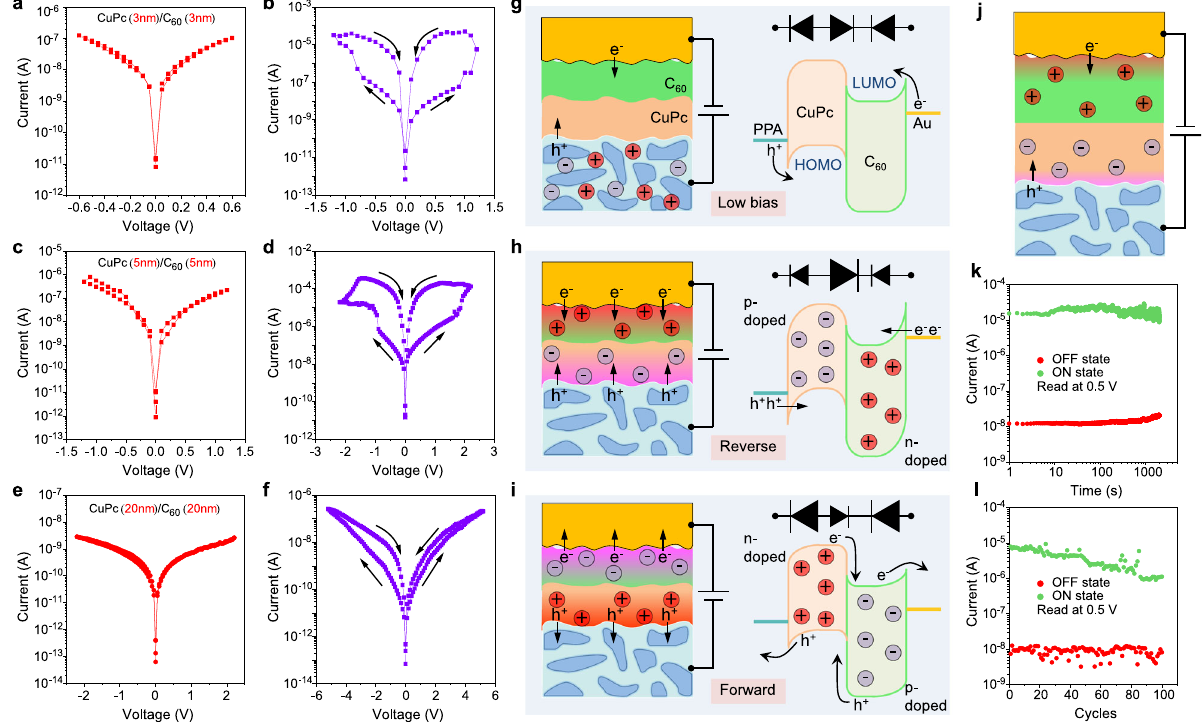
Fig. 4 Molecular bipolar memristors based on PPA60/CuPc ( x nm)/C 60 ( x nm)/Au tube. a – f I - V characteristics of the molecular devices in different voltage windows (( a ) and b , x = 3 nm; c and d , x = 5 nm; e and f , x = 20 nm). In the low applied voltage range, the molecular devices show nearly symmetric I - V curves without a loop. At higher voltages electric hysteresis loops appear. g – i Schematic showing the molecular devices with an ultrathin molecular hybrid layer ( g low bias; h high reverse bias; i high forward bias). The red gradient area represents the n-doped region induced by cation accumulation, while the purple gradient area represents the p-doped region induced by anion accumulation. When fi rstly biased by a high reverse voltage, ion polarization makes the system similar to a diode dominated by the p-n junction ( h and Supplementary Fig. 13d). When fi rstly biased by a high forward voltage, the system can be considered as a diode dominated by the two Schottky junctions ( i and Supplementary Fig. 13e). j Schematic illustration of the molecular devices with thick molecular hybrid layers under reverse bias, in which the accumulated ions have a much weaker modulation effect for carrier injection due to the ineffective ion polarization and relatively low ion concentration. k Retention of ON and OFF states of PPA60/CuPc(3 nm)/C 60 (3 nm)/ Au under continuous read-out voltages (at 0.5 V). The device is switched to the ON state by applying a positive voltage pulse at 1.5 V for a few